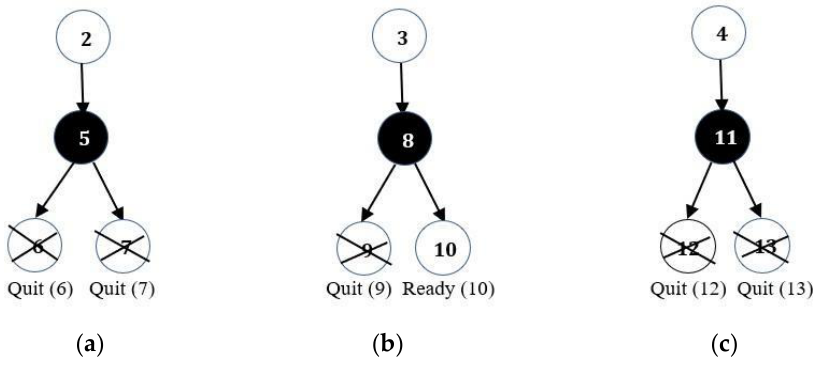
Figure 11. Negotiation graphs for the three guests: ( a ) DF2, ( b ) DF4, and ( c ) DF6.